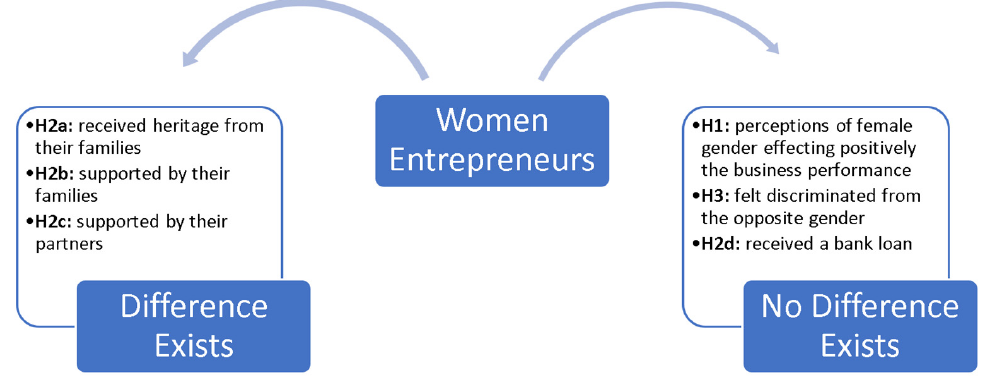
Figure 6. Difference existence between women entrepreneurs and other Figure 6 . Di ff erence existence between women entrepreneurs and other factors.